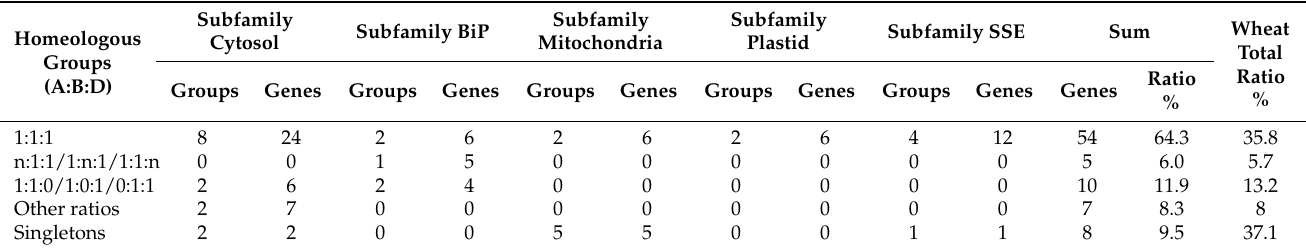
Table 1. Groups of homeologous HSP70s in hexaploid